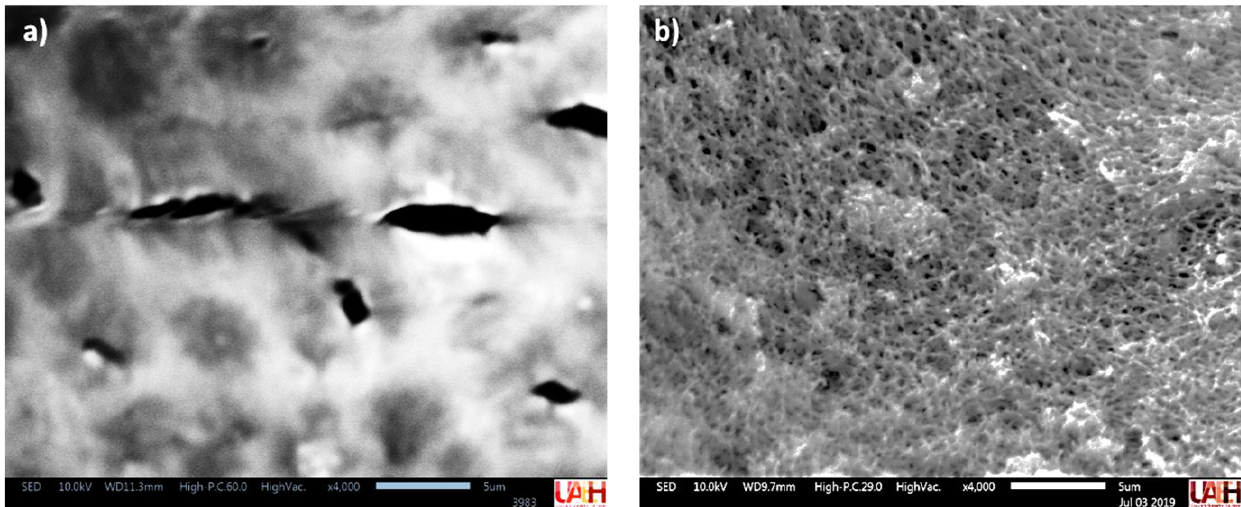
Figure 1. SEM microphotographs of membranes. ( a ) CA, ( b )